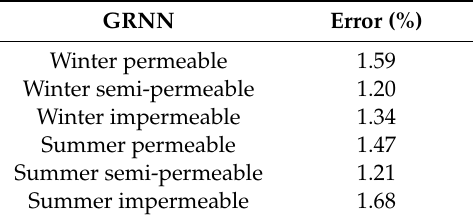
Table 1. Average percentage of incorrect predictions.